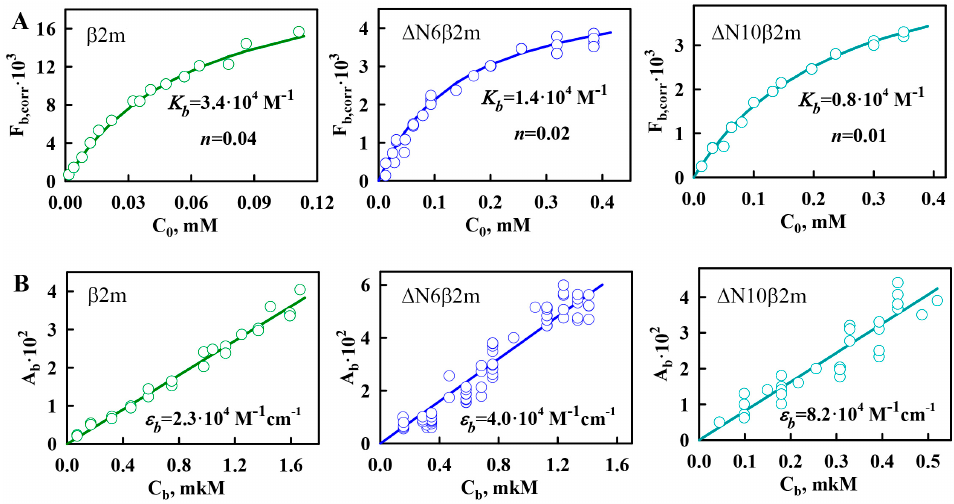
Figure 4. Cont. Figure 4.